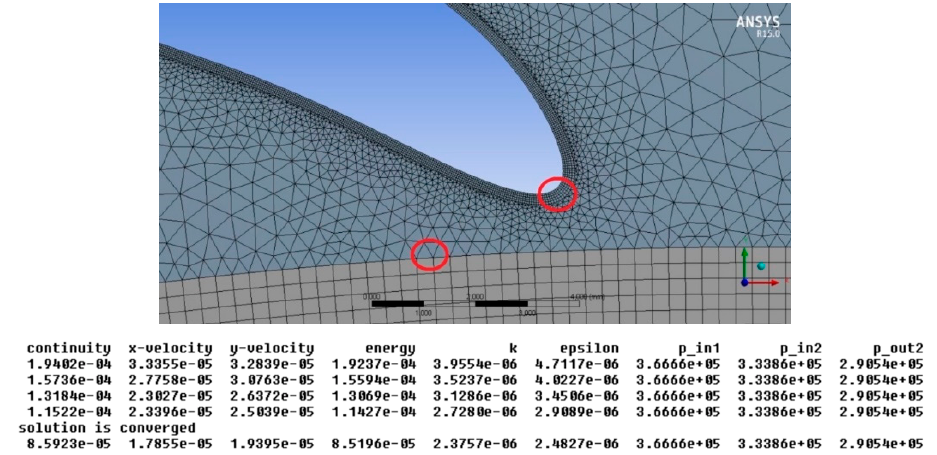
Figure 13. Mesh quality before refinement.